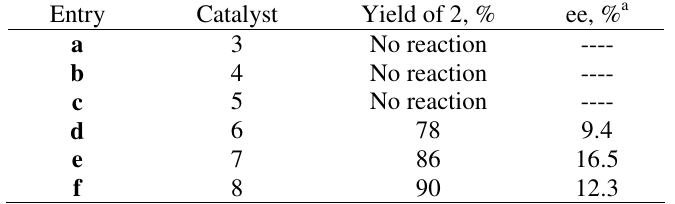
Table 1. The Effect of chiral PTCs 3-8 on the enantioselectivity in epoxidation of chalcone ( 1) Entry Catalyst Yield of 2, % ee, % a a 3 No reaction ---- b 4 No reaction ---- c 5 No reaction